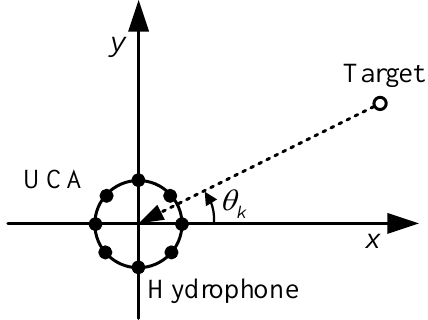
Figure 1. Configuration of the UCA-based measurement system.